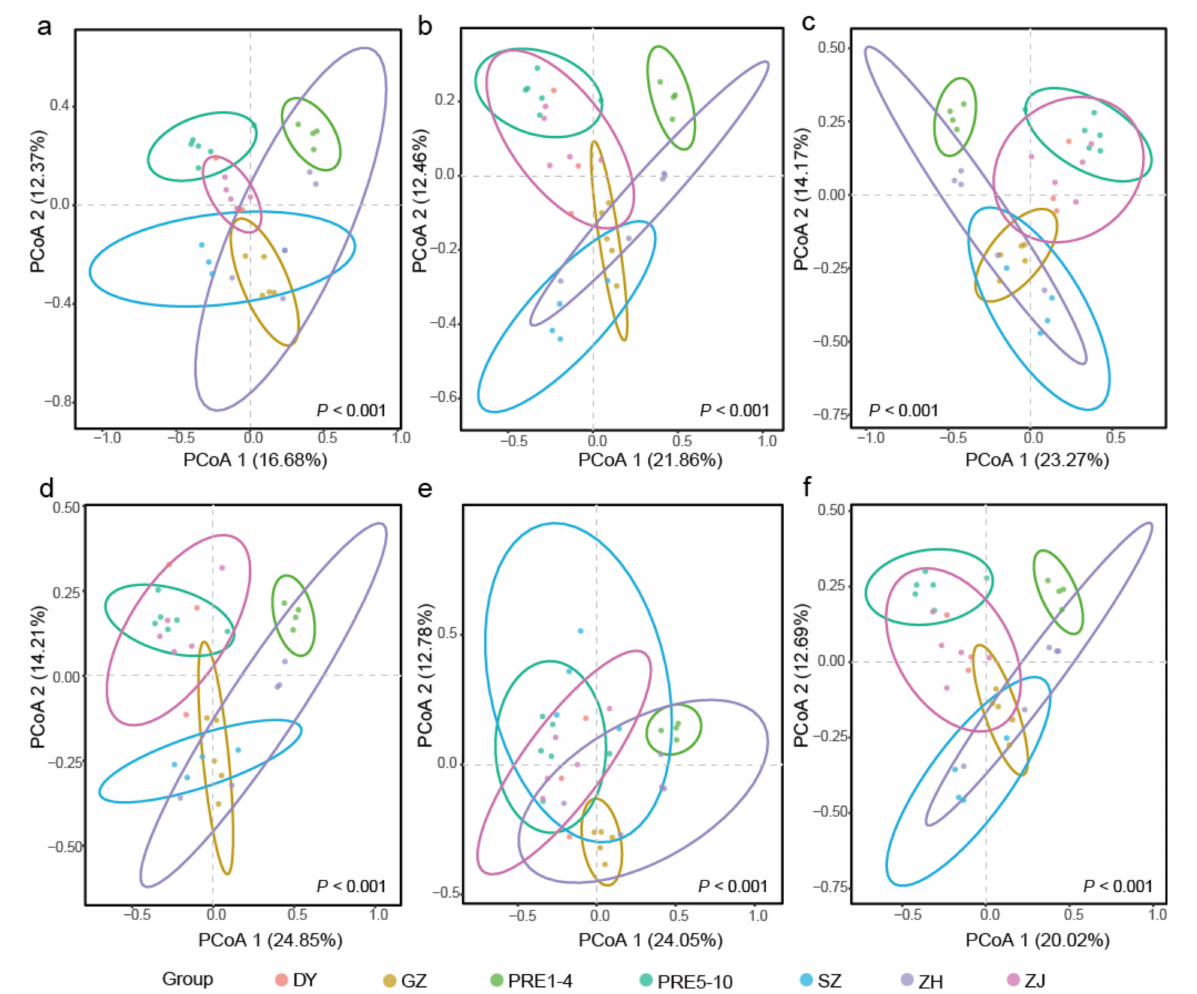
Figure 3. The distributions of oligotrich (s.l.) communities from six datasets (( a ). DADA2–100; ( b ). SWARM–100; ( c ). UNOISE–100; ( d ). UPARSE–97; ( e ). UCLUST–97; ( f ). UCLUST–99) based on Principal Co-ordinates Analysis (PCoA). Samples from the same sampling area are indicated by the same color except for samples from PRE. Samples named PRE1–4 and PRE5–10 are indicated by different colors. The ellipses represent 95% confidence intervals except for DY (too few samples to calculate an ellipse). P represents global significance among oligotrich (s.l.) communities from different sampling areas based on ADONIS. p values < 0.05 indicate significant differences among community